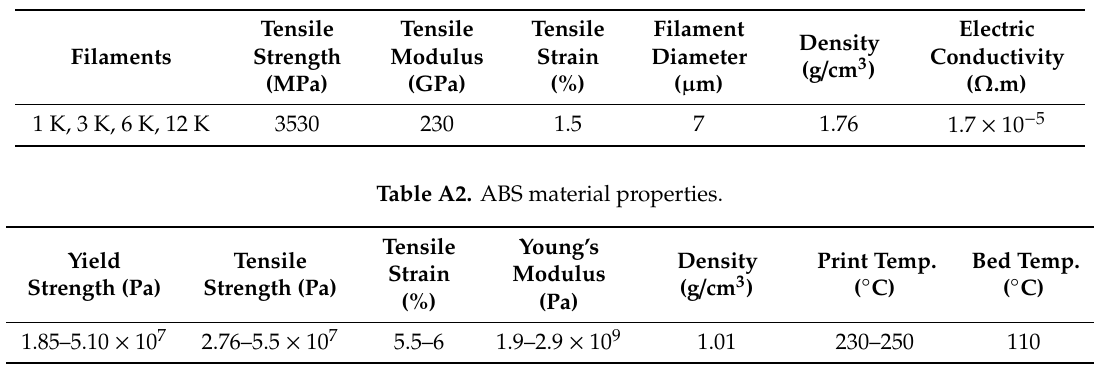
Table A1. General properties of the fiber filaments.